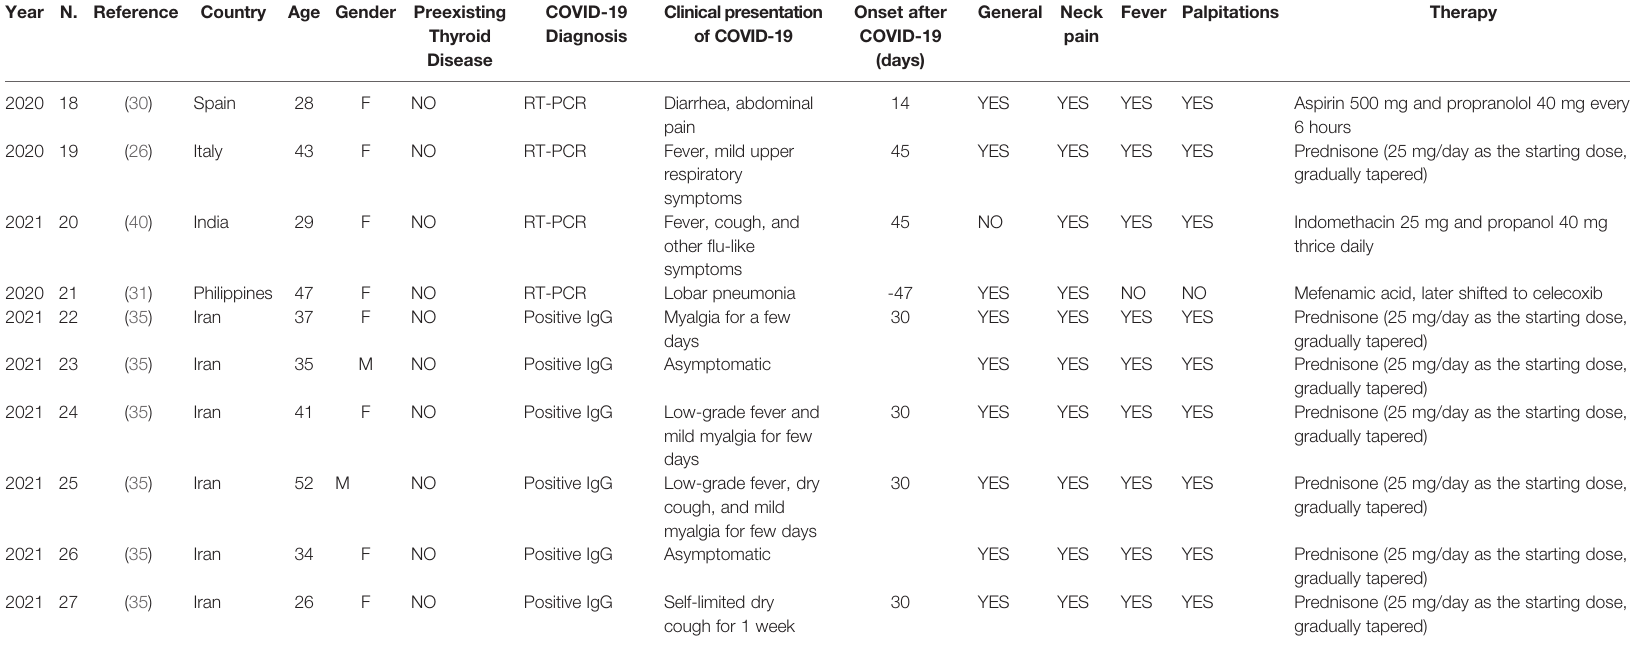
b While on morphine for back surgery. c Atrial fi